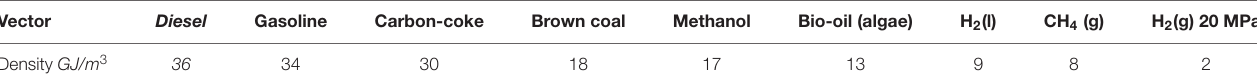
TABLE 2 | Energy density of some energy sources/vectors.